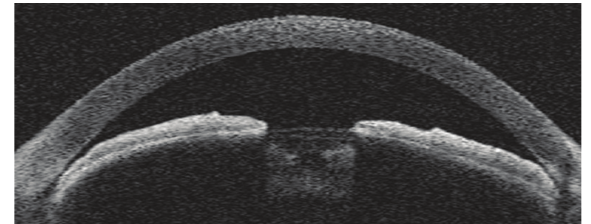
Figure 2: Qualitative assessment of narrow angle and shallow anterior chamber by AS-OCT.